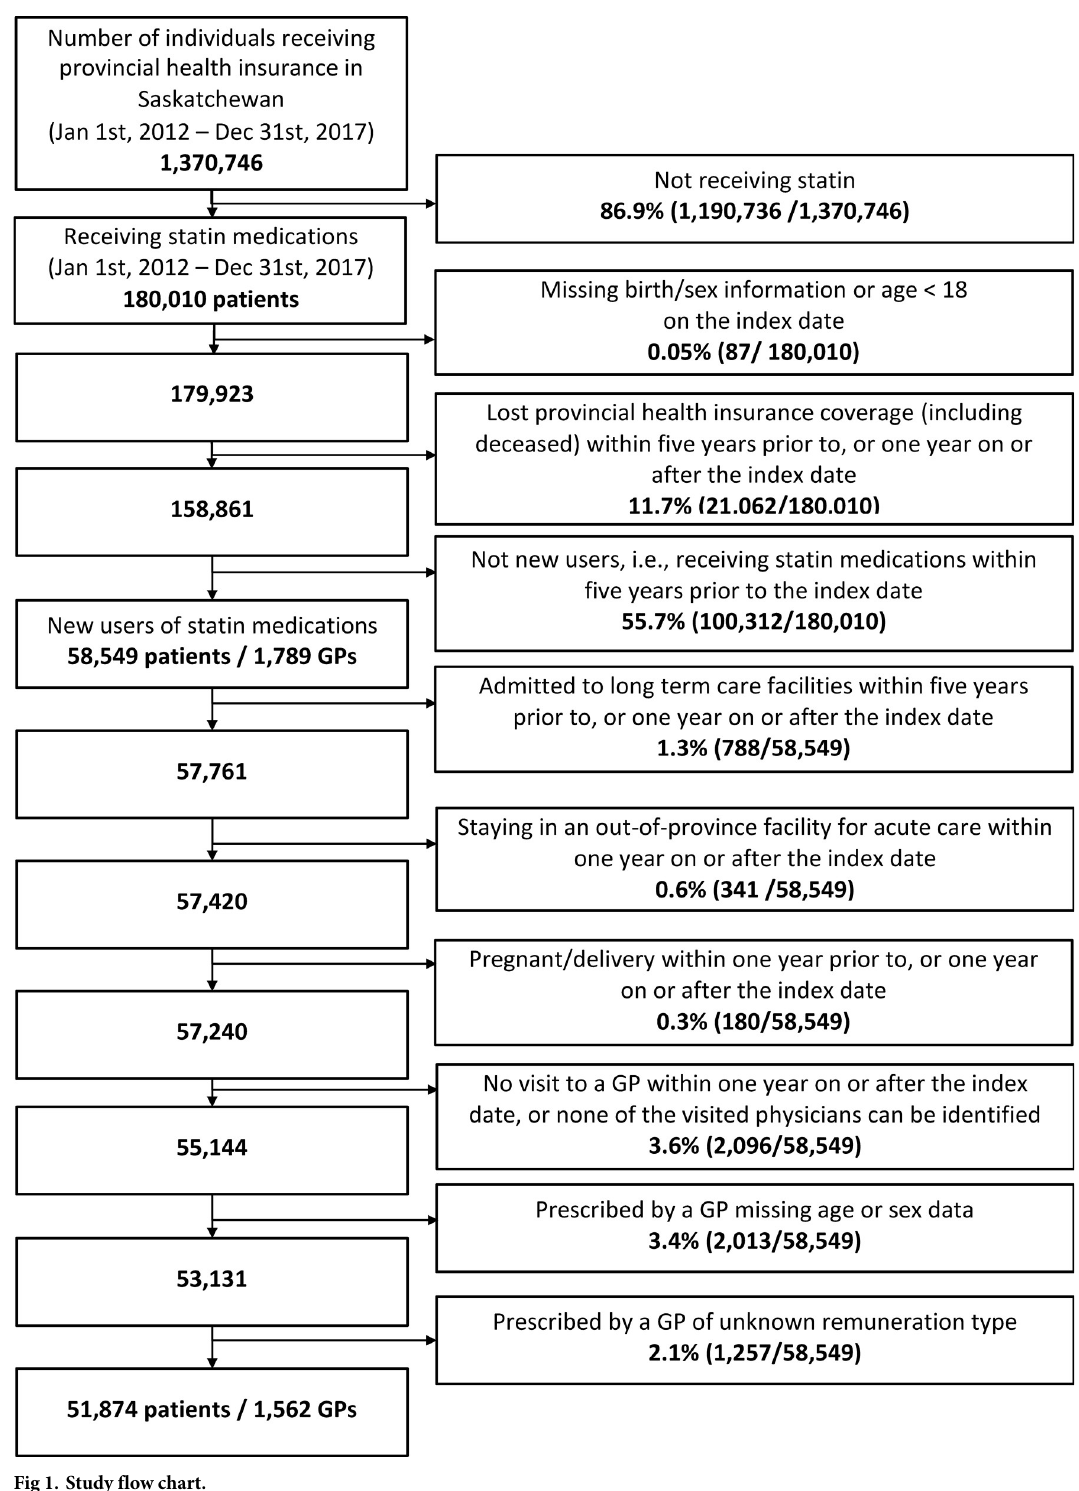
Fig 1. Study flow